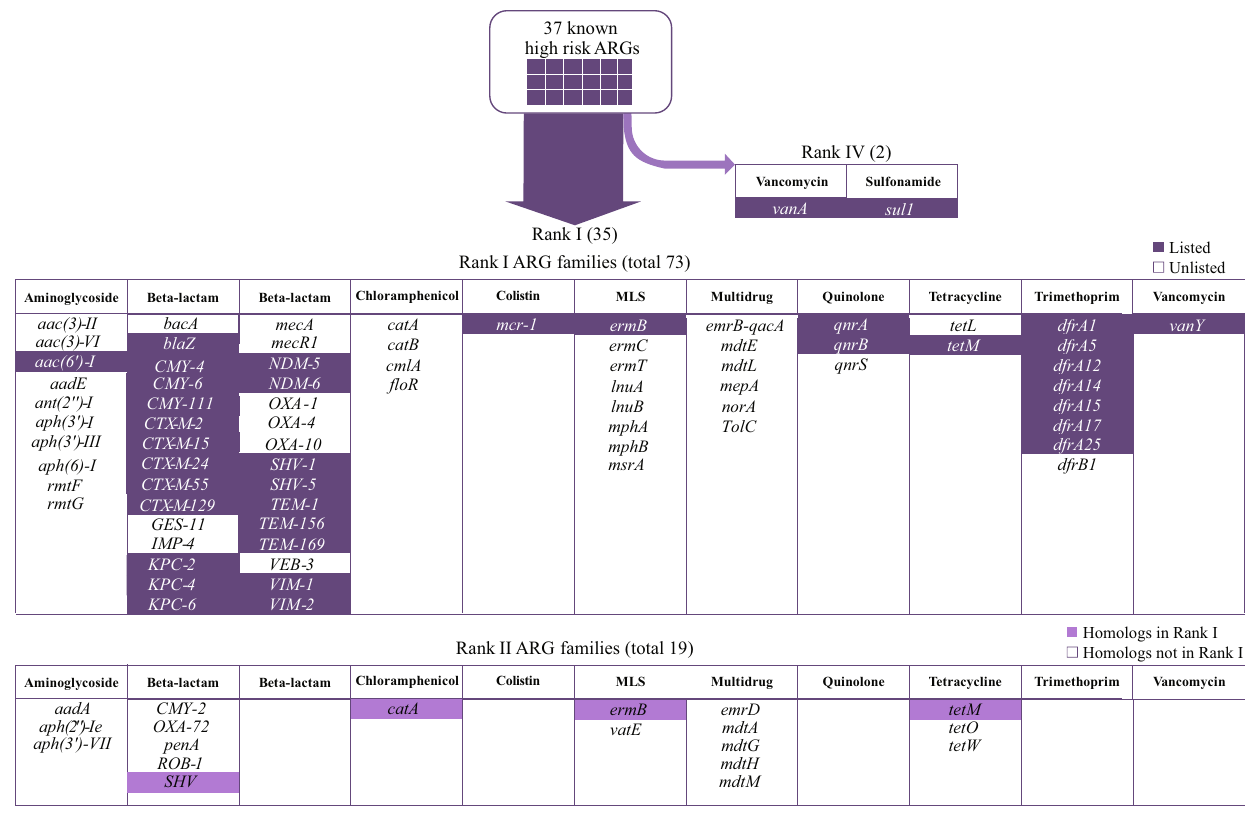
Fig. 3 The risk ranks of 37 known high risk ARG families identi fi ed by World Health Organization (WHO) and literature review (highlighted in dark purple) (referred to as “ listed ” ARGs), 73 Rank I ARG families of the initial set, and 19 Rank II ARG families of the initial set. “ Listed ” (WHO-listed) represented Rank I ARGs that were reported to cause problems in hospitals and/or have been widespread on mobile genetic elements by previous literatures (highlighted in dark purple). “ Unlisted ” represented Rank I ARG families that were not reported in previous studies as high risk ARGs. “ Homologs in Rank I ” represented Rank II ARGs with homologous Rank I ARGs of the same gene family (highlighted in light purple). ARGs antibiotic resistance